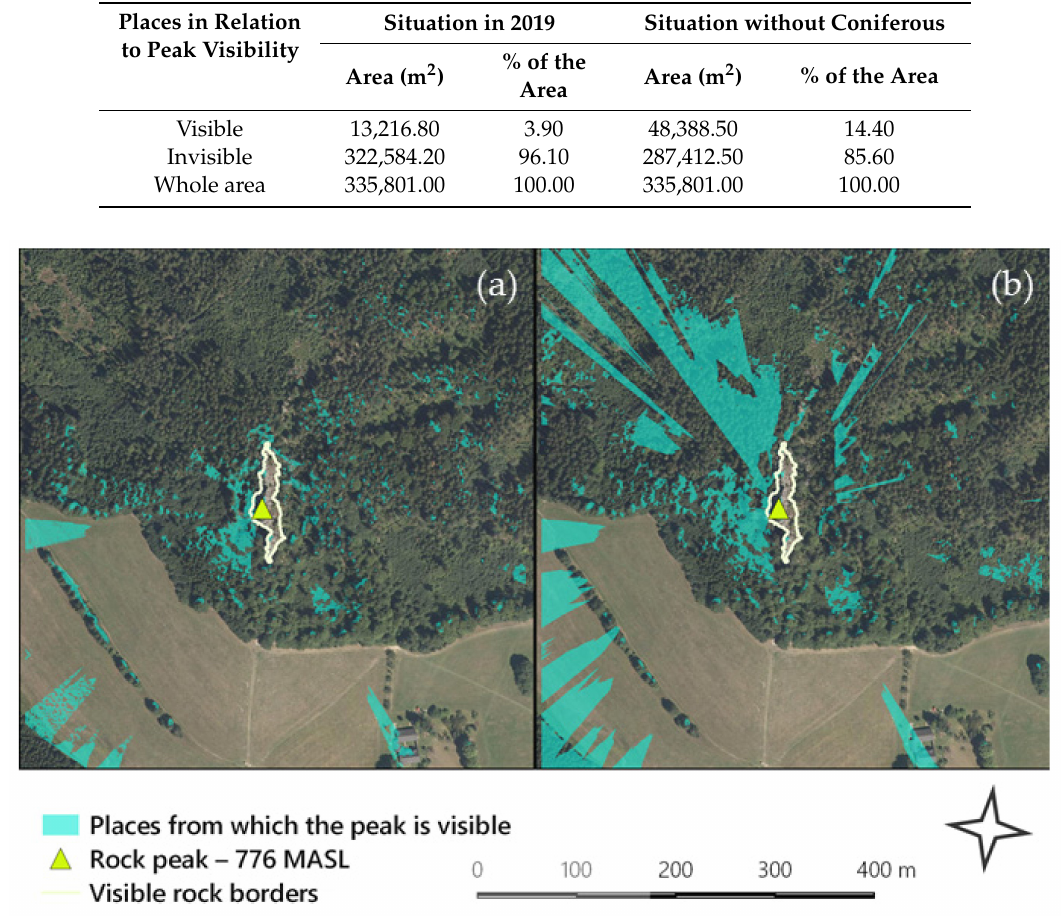
Figure 11. The results of the visibility analyses: ( a ) contemporary situation of the forest stand and ( b ) visibility conditions using the model without conifers (gained by NDVI